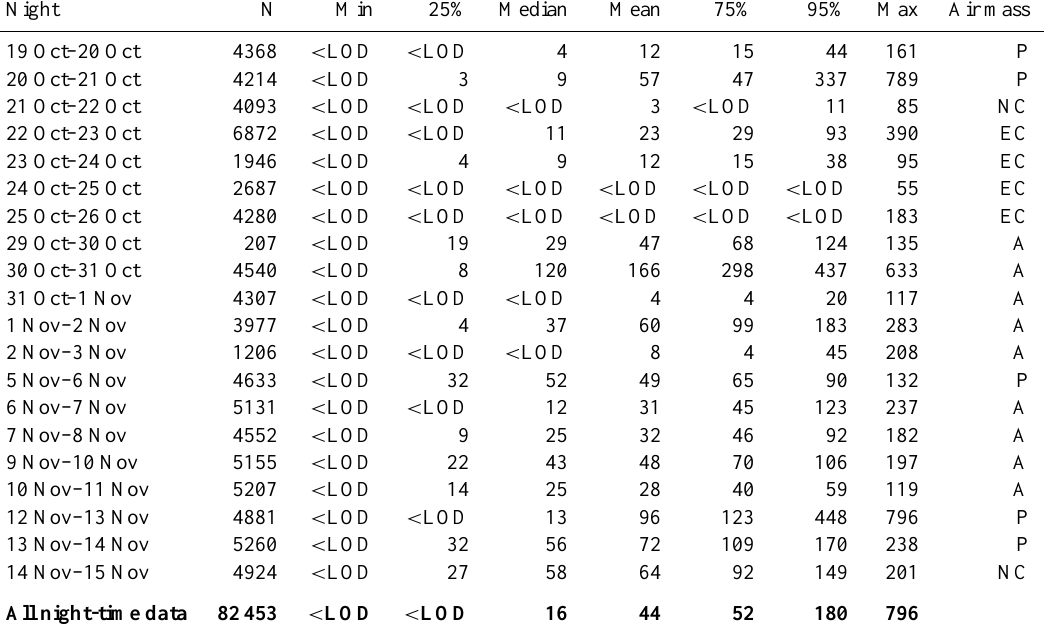
Table 1. Statistics for night-time measurements of [NO 3 +N 2 O 5 ]/pptv. Night-time as defined by sunrise/sunset times. N: dataset size; 75% and 95% refers to 75th and 95th percentile; All data < LOD replaced with the median of the variable detection limit of around 2pptv and zero. Air masses grouped as indicated by a general inspection of 5-day back trajectories (Rolph, 2003) and coded by predominant origin